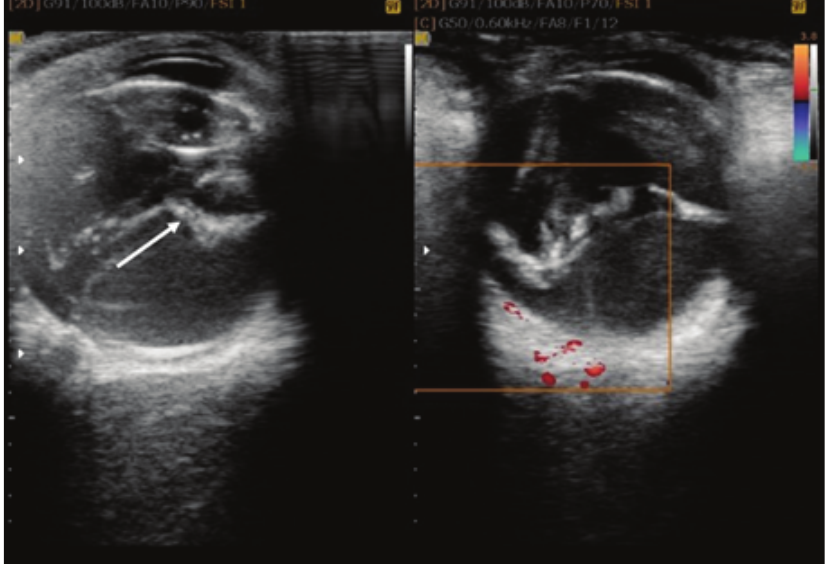
Figure 3. Color Doppler ultrasonography shows no flow in the membrane seen in the left figure, ruling-out RD. The avascular membrane has been marked in the right